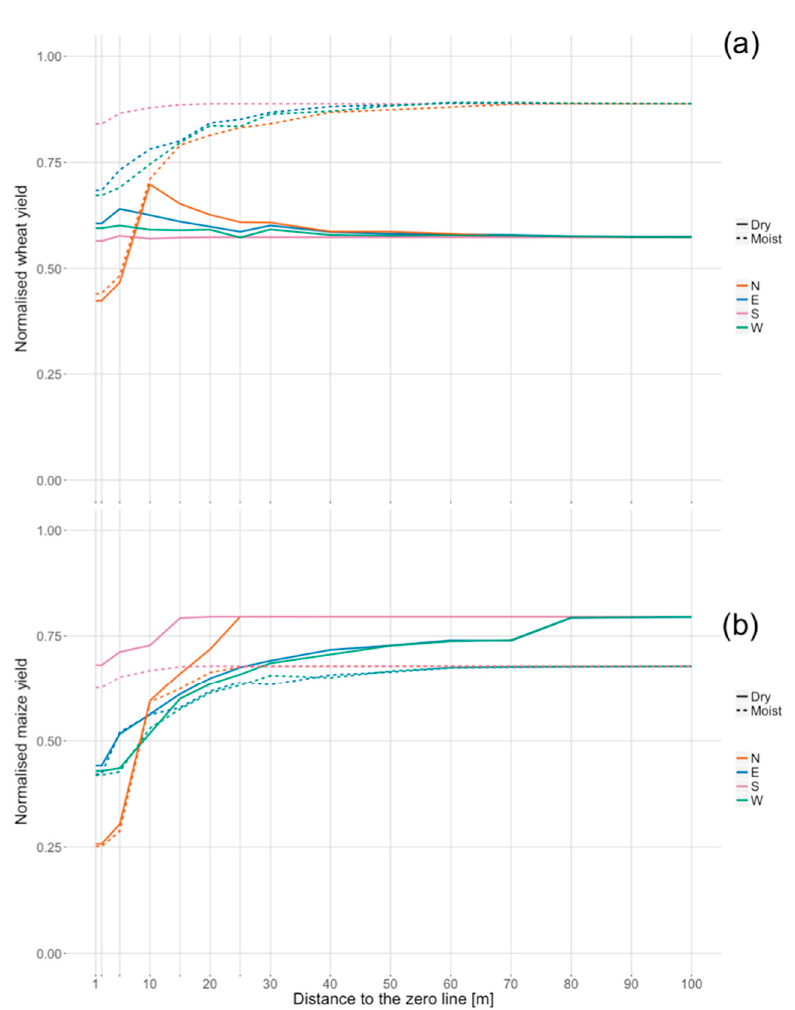
Figure 6. Simulated yields for wheat ( a ) and maize ( b ) in the four cardinal directions (north, east, south, and west), with respect to distance to the zero line and the resulting shading of a forest matrix. The solid line represents the mean for the three driest years and the dashed line represents the mean of the three wettest years, within the 30 years of climate data.